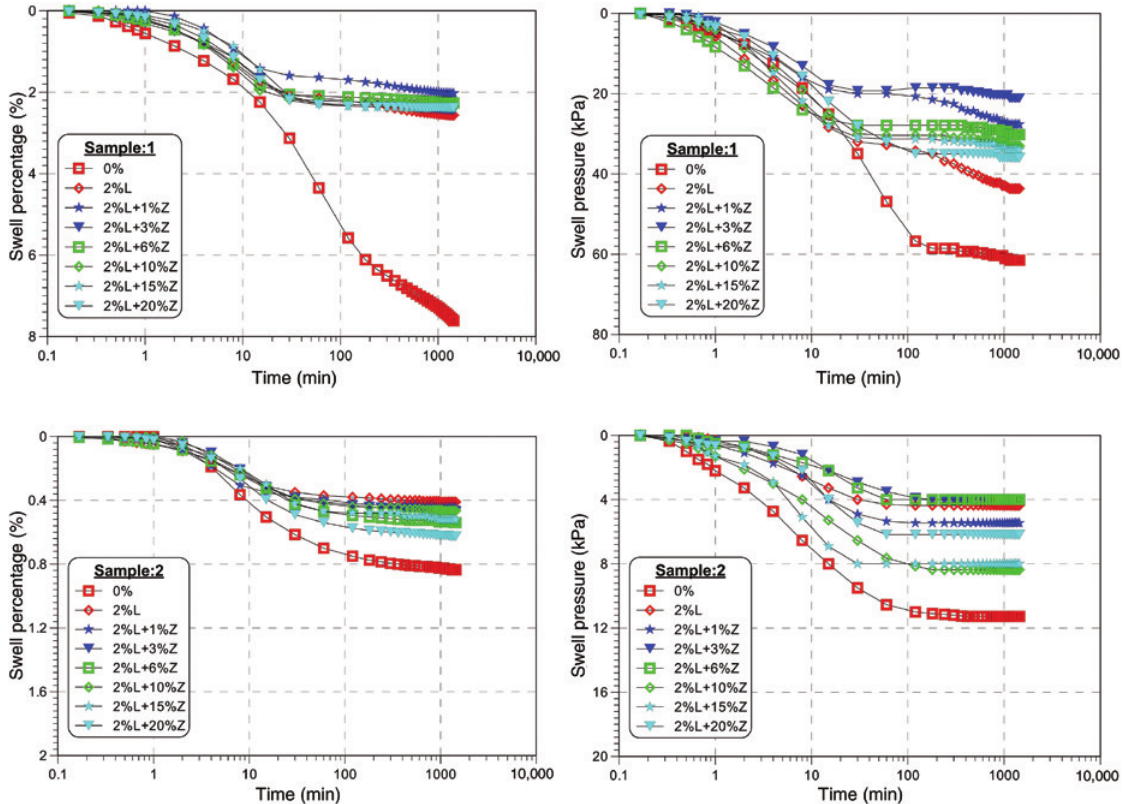
Figure 3: Swell percentage and swell pressure vs. time plots for samples mixed with different additive contents.